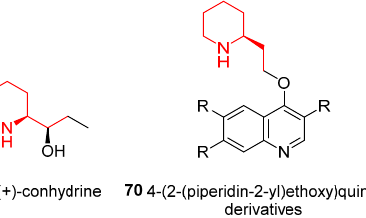
Figure 8. Structure of (+)-conhydrine and general structure of 4-(2-(piperidin-2-yl)ethoxy)quinoline derivatives.